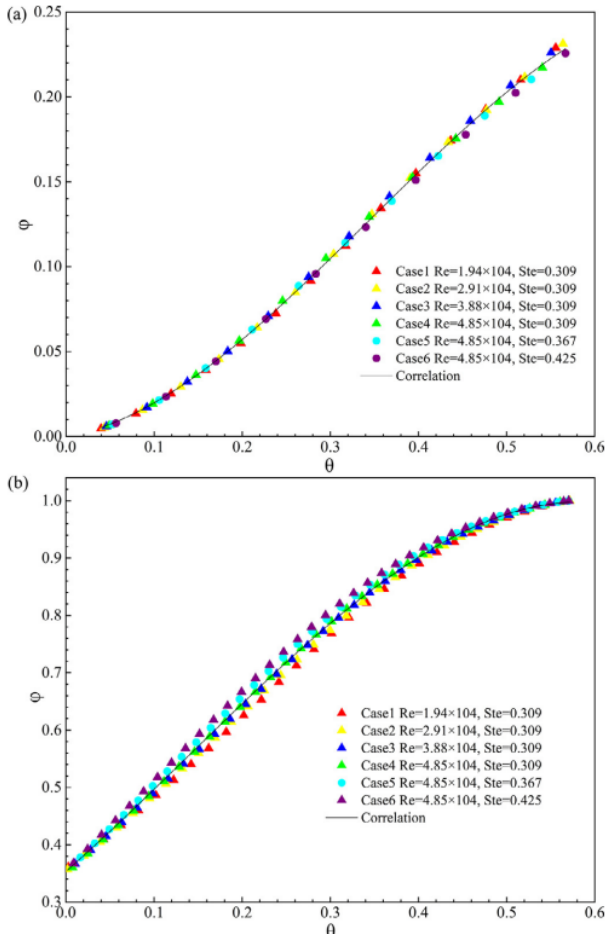
Figure 27. Overall results for melting fraction against θ with different Stefan numbers and Reynolds numbers in the first stage ( a ) and second stage ( b ). Reprinted with permission from Ref. [48]. 2020, Elsevier.